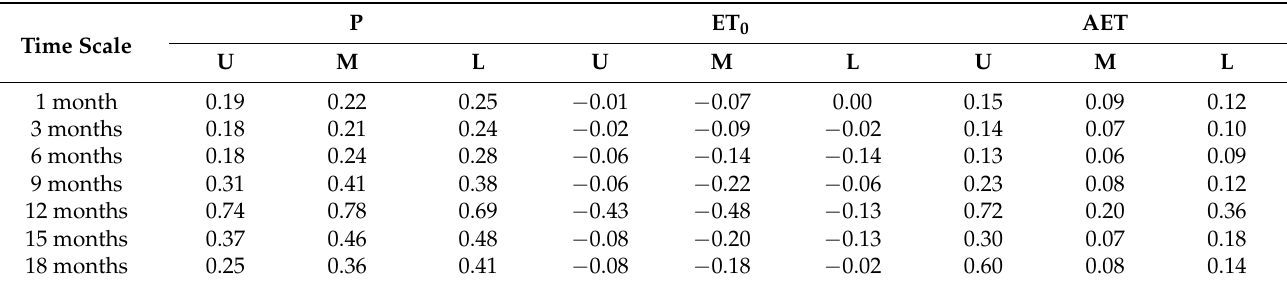
Table 3. Pearson’s correlation coefficient between sc-PDSI and P, ET 0 , AET at different time